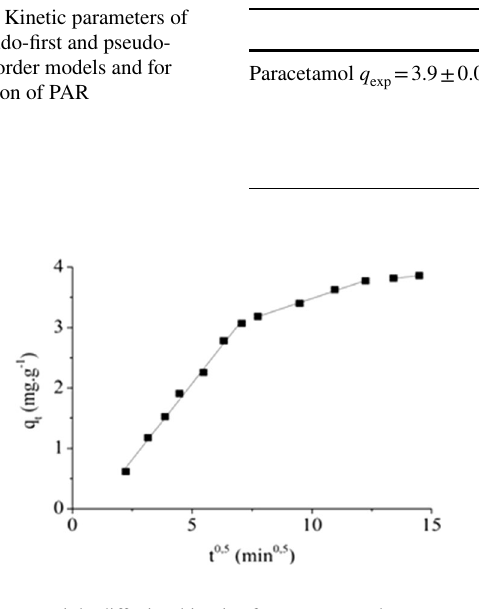
Fig. 5 Intraparticle diffusion kinetics for paracetamol